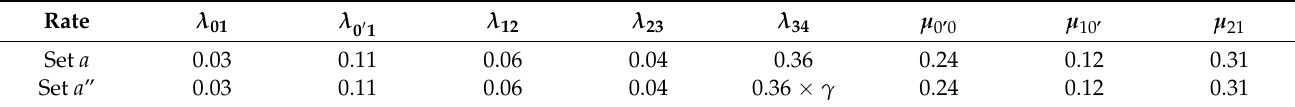
Table 5. State transition rate (per hour) values used for numerical analysis of the ALP.